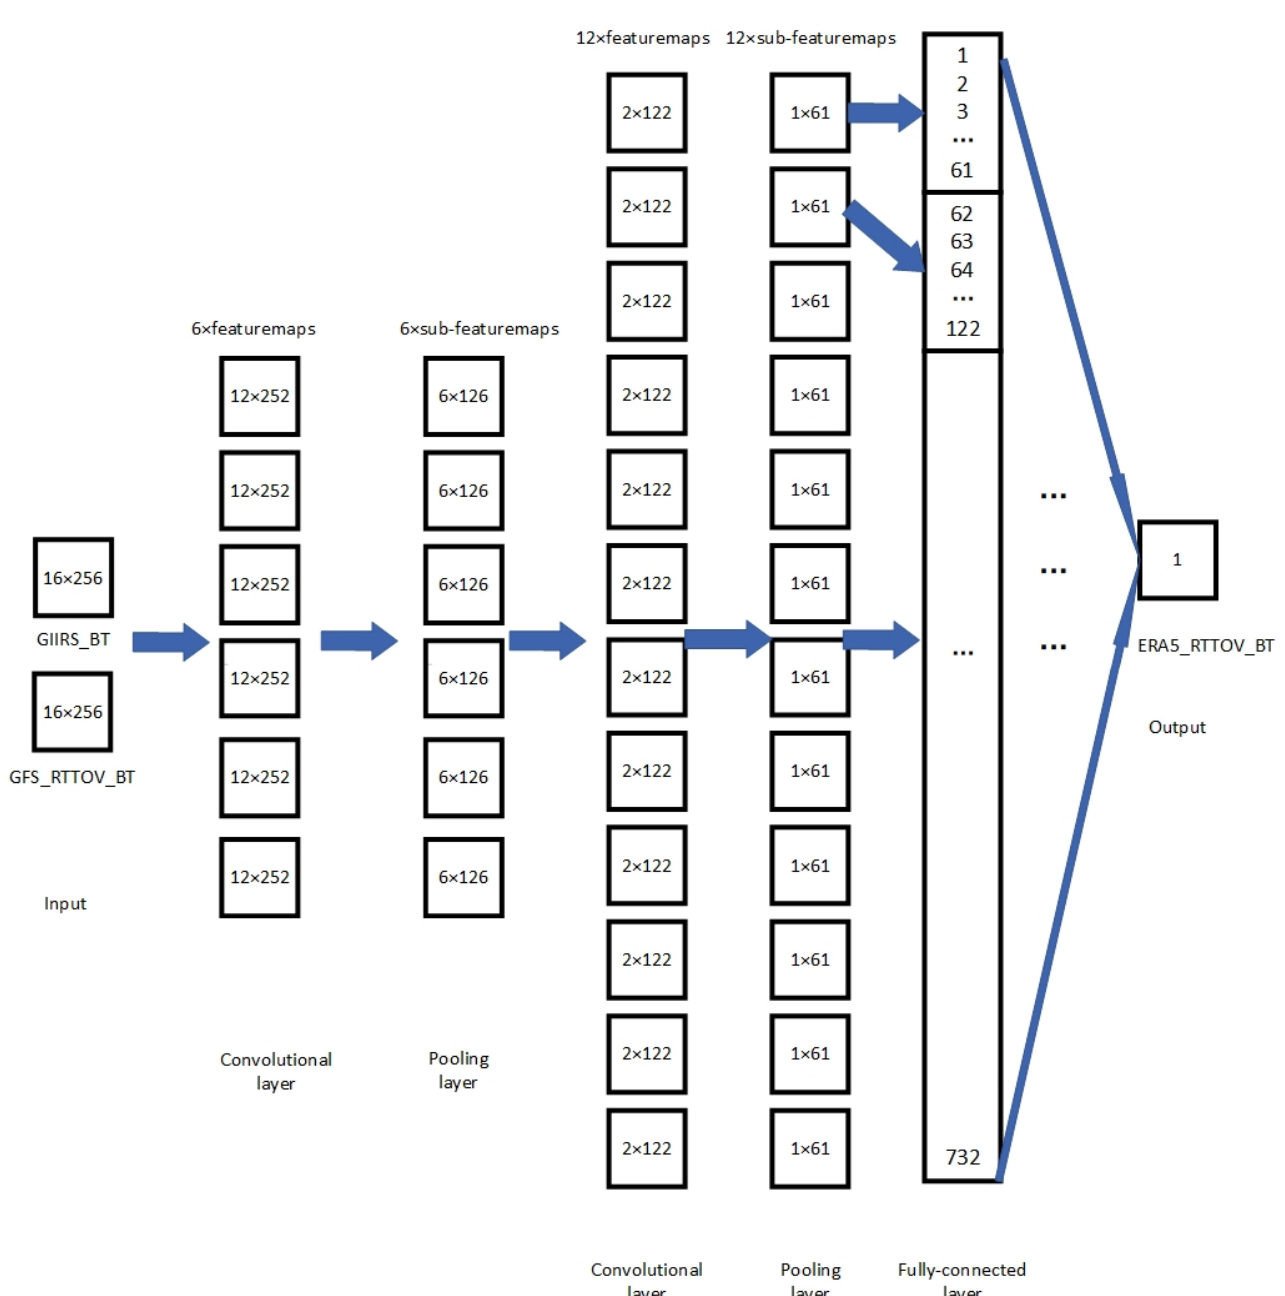
Figure 4. The convolutional neural network structure of our method.